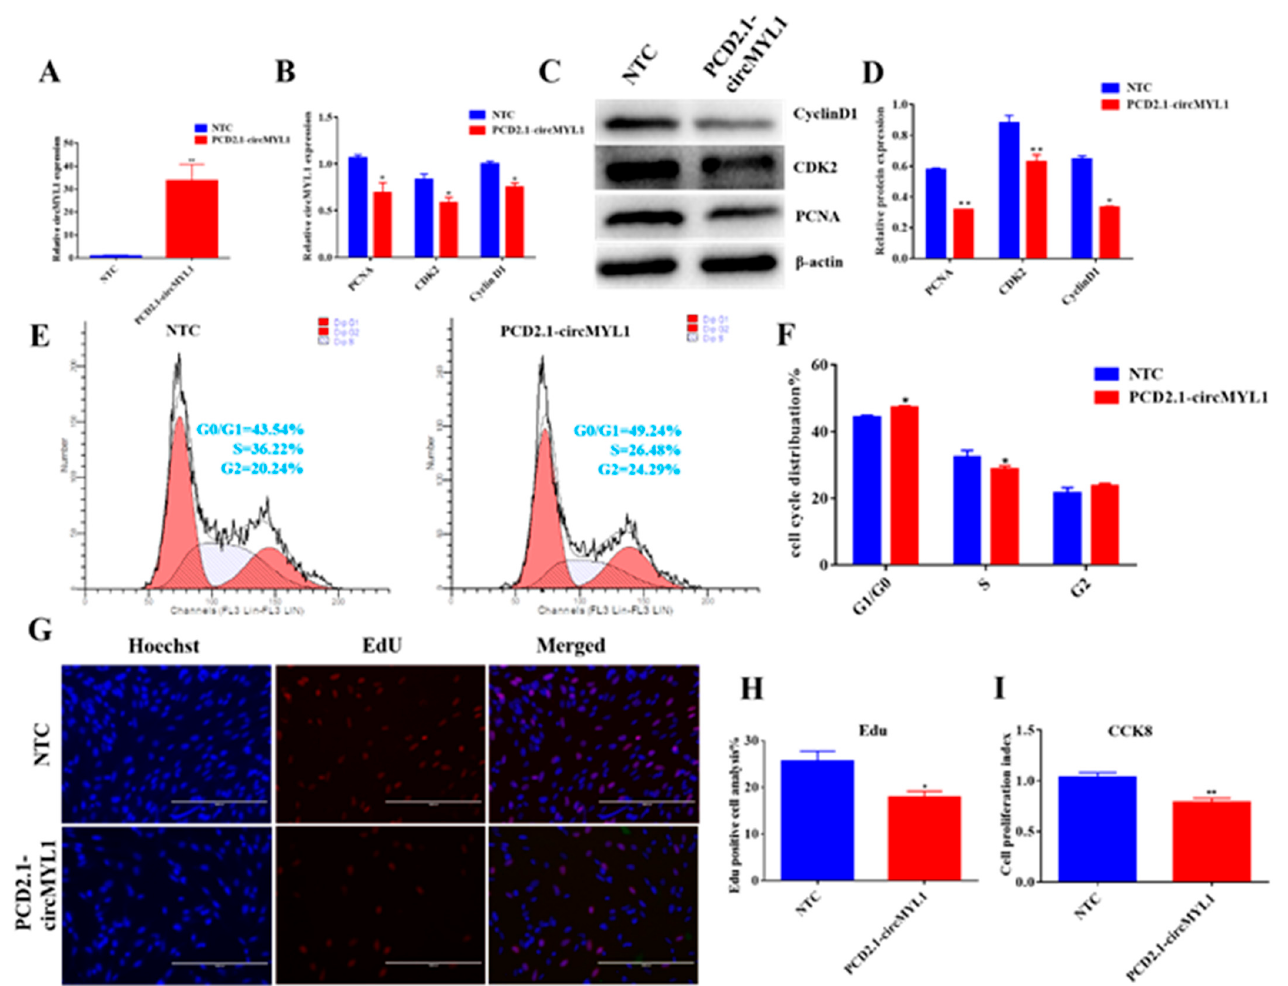
Figure 2. The overexpression of circMYL1 inhibits the proliferation of bovine primary myoblasts. ( A ) qRT-PCR detected the efficiency of the circMYL1 overexpression vector pCD2.1-circMYL1. ( B ) qRT-PCR detected the relative expression levels of proliferation marker genes PCNA , CDK2 , and CyclinD1 . ( C ) Western blot detected the protein expression levels of proliferation marker genes PCNA , CDK2 , and CyclinD1 . ( D ) Histogram graph showing the protein band density evaluated using ImageJ. ( E ) Bovine primary myoblasts were transfected with pCD2.1-circMYL1, and the cell cycle was analyzed by flow cytometry. ( F ) Histogram graph showing the number of cells in each phase of the cell cycle. ( G ) The cell proliferation was detected by 5-ethynyl 2 ′ -deoxyuridine (EdU) assay after transfection of pCD2.1-circMYL1. EdU staining (red) for positive cells. DAPI staining (blue) for the cell nuclei. Scale bar, 200 μ m. ( H ) Graph of a histogram showing the percentage of EdU-positive cells, and counted using ImageJ. ( I ) The cell counting kit-8 (CCK-8) assay was used to detect the cell proliferation index. Data are shown as mean ± SEM. n = 3. * p < 0.05; ** p < 0.01.